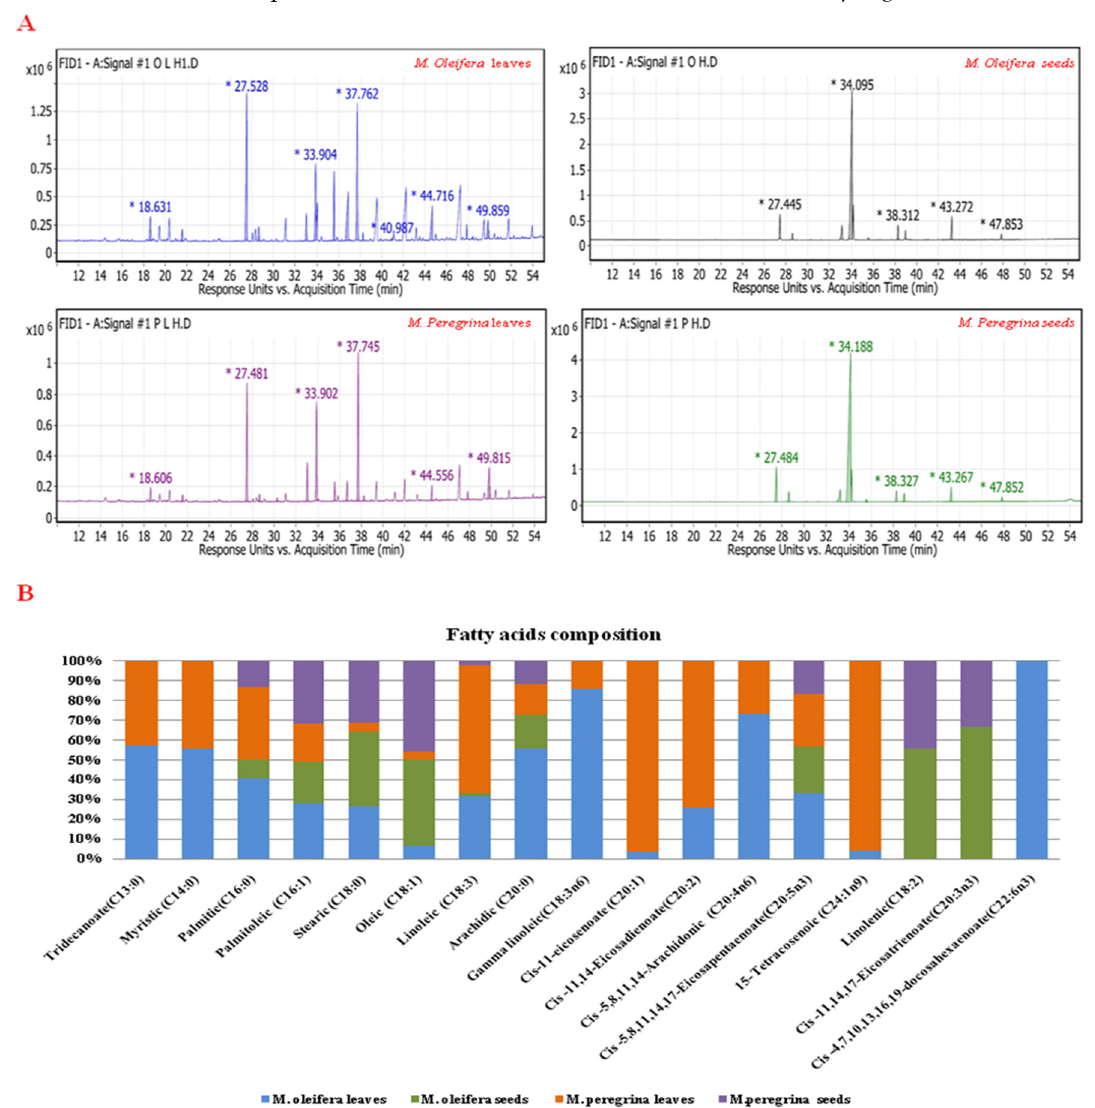
Figure 2. Typical GC-FID chromatogram for fatty acids (FA) from leaves and seeds of M. oleifera and M. peregrina . ( A ) GC-FID Peak of the extracts, ( B ) the percentage of each fatty acids (FA) compounds in the four extracts. Table 2. Fatty acid composition (%) from leaves and seeds extracts of M. oleifera and M. peregrina.